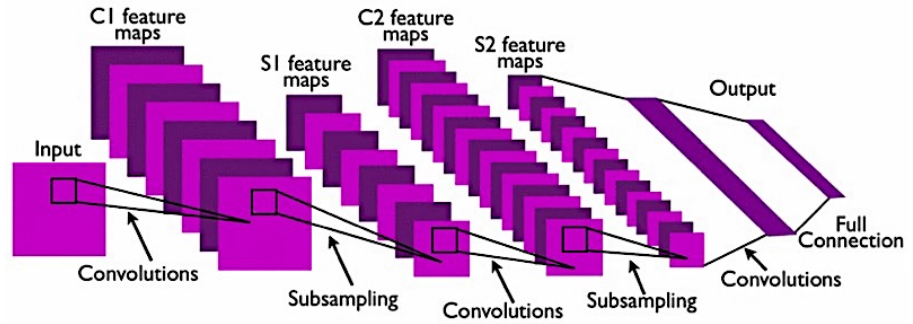
Figure 13. Basic structure of a CNN architecture [134].